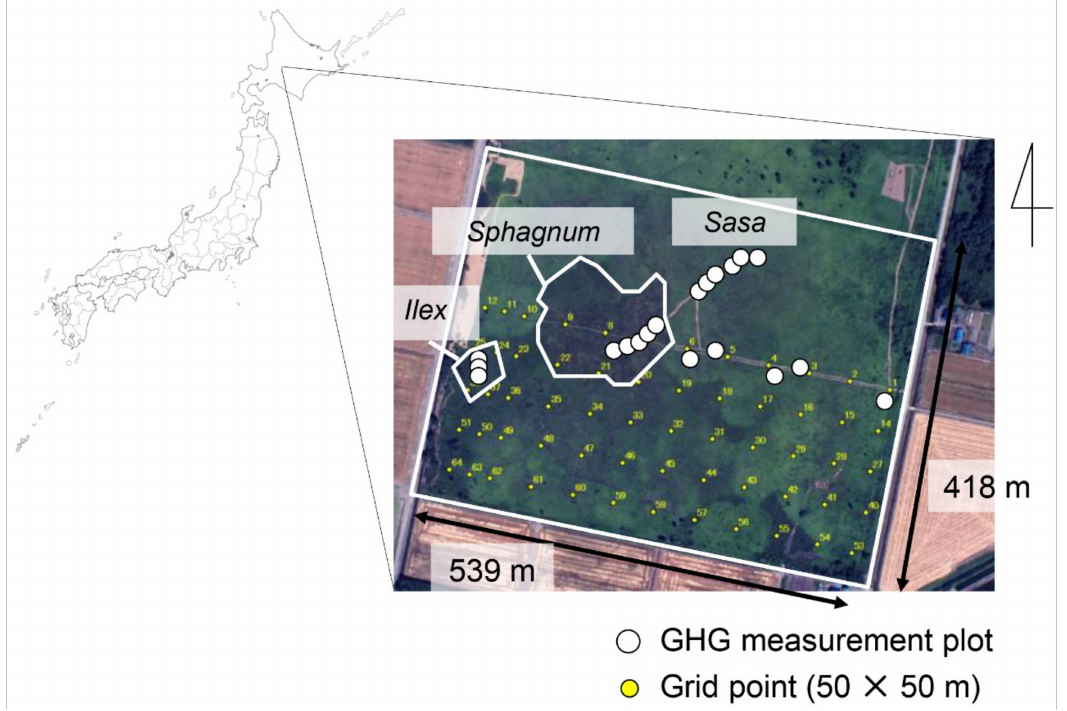
Figure 1. Location of the study field (Bibai Wetland) and survey points.